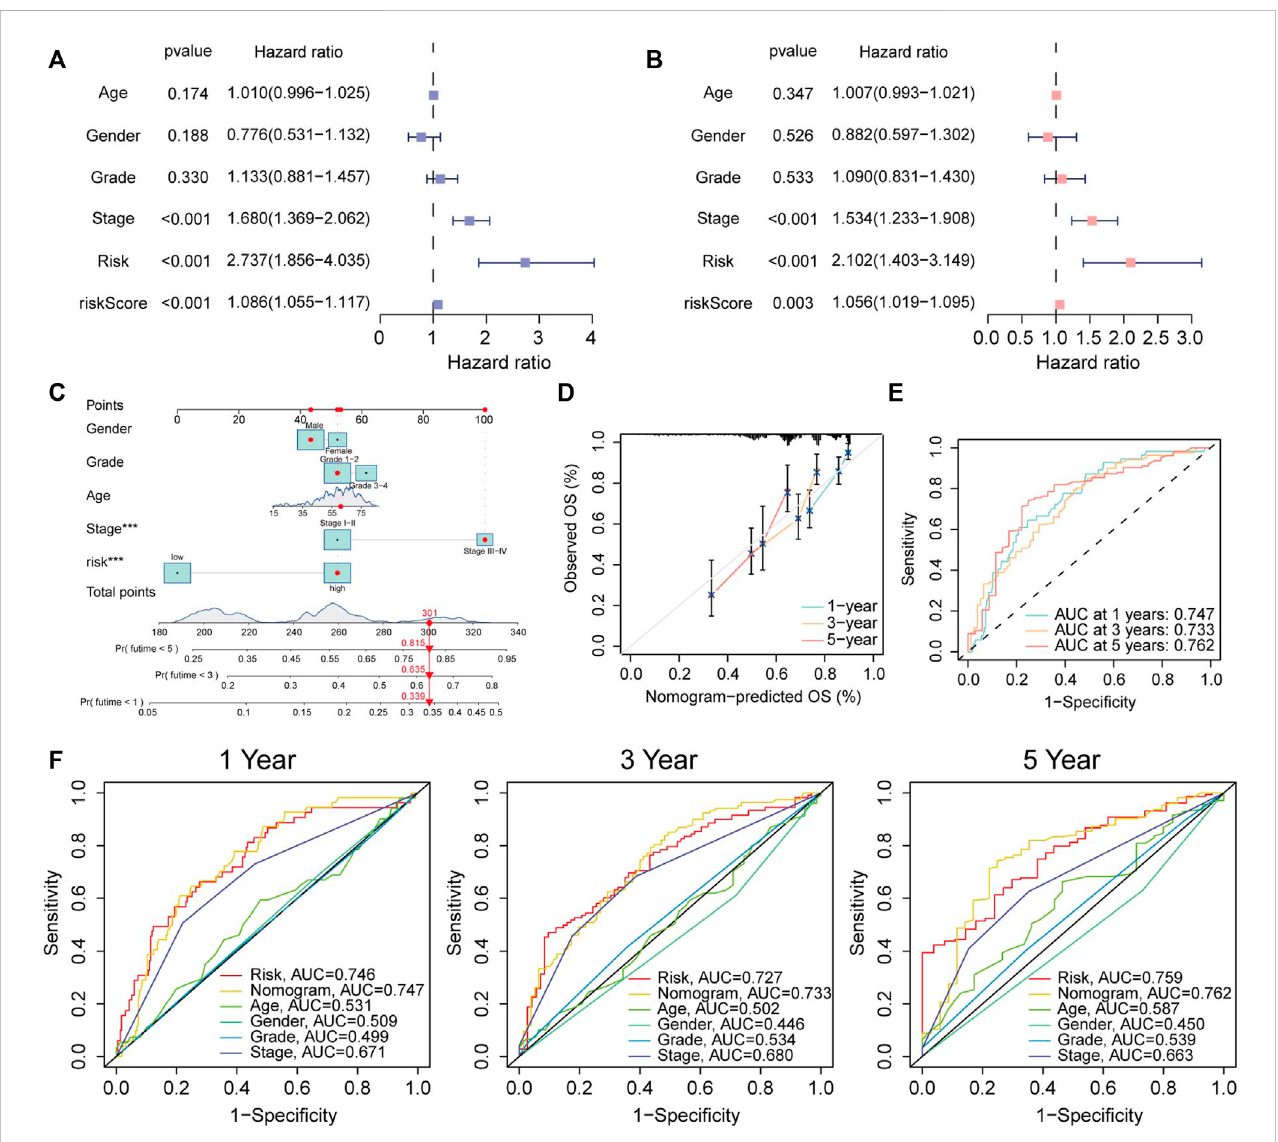
FIGURE 11 Construction and evaluation of nomogram. (A) Stage, risk, and risk score were considered signi fi cant. (B) Multivariate Cox regression analysis showed stage, risk, and risk score were independent prognostic predictors. (C) 1, 3, 5-year survival rates predicted by Nomogram. (D) The predictive abilities of nomograms in 1, 3, and 5 years of survival were evaluated by calibration. (E) ROC curves re fl ect the accuracy of OS predicted by nomogram. (F) The AUCs value of CRLs model and clinical characteristics for predicting 1, 3, 5 years survival. * p < 0.05, ** p < 0.01, *** p <